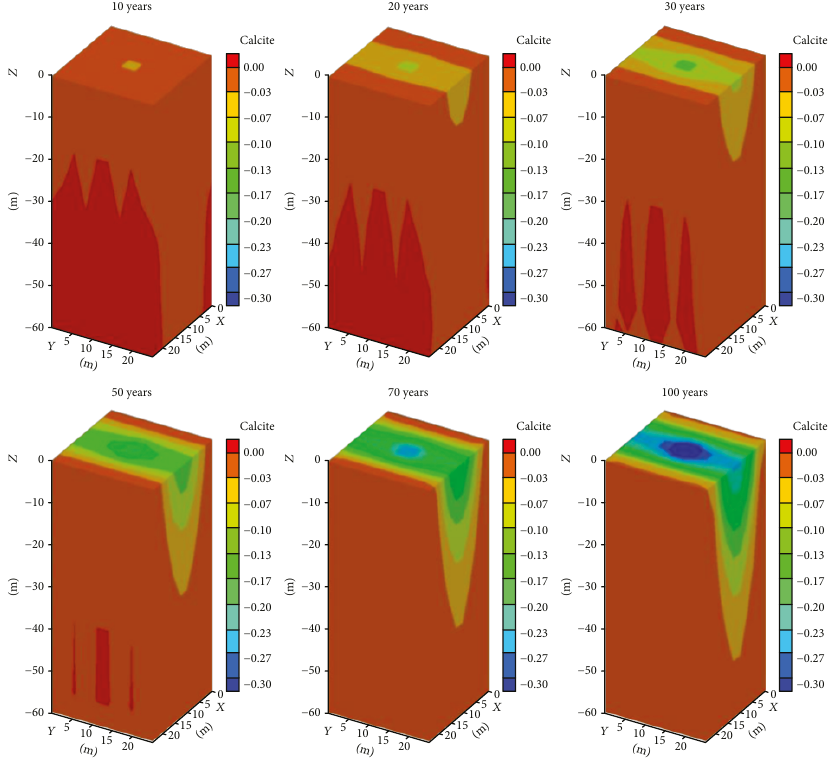
Figure 14: The corrosion range of the fi ssure under medium hydrodynamic conditions-medium permeability — 20 °